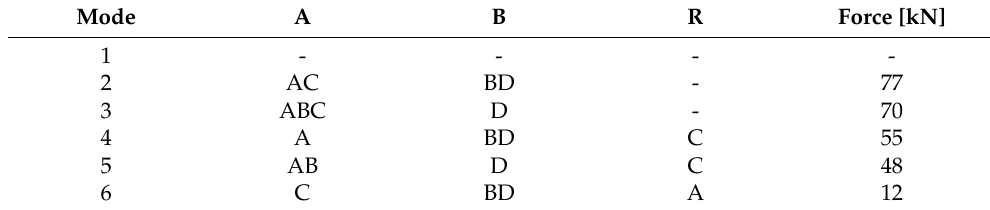
Table 1. Available modes and connected